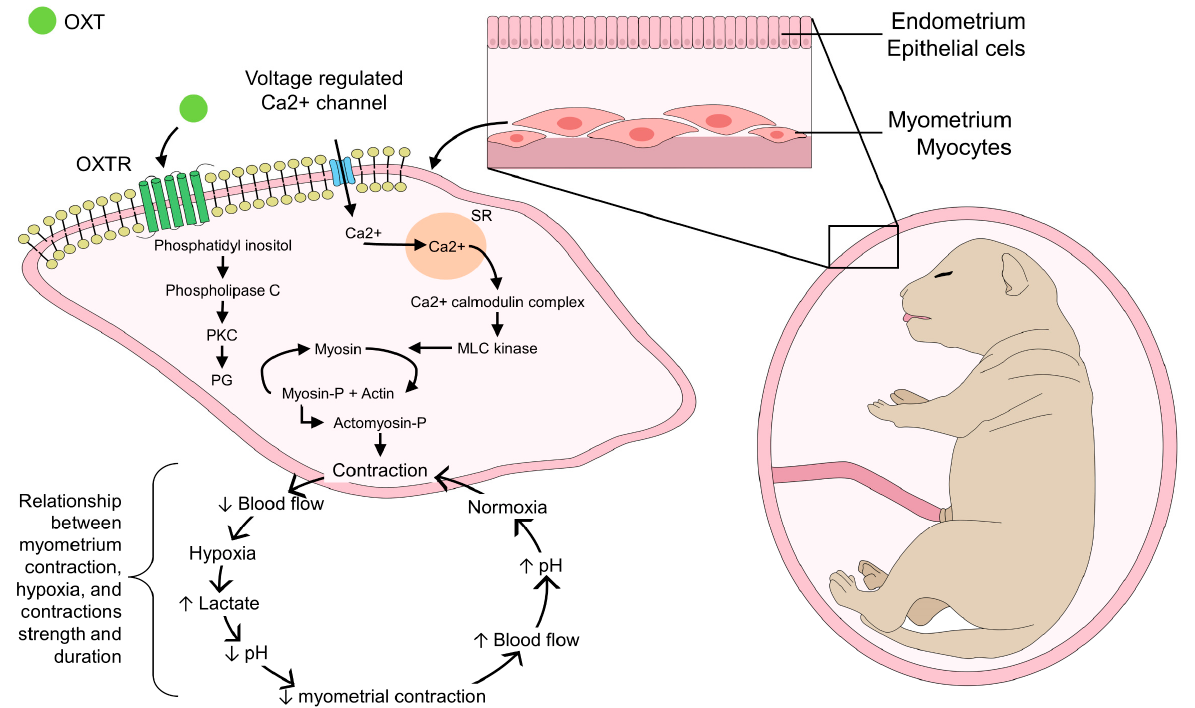
Figure 1. Mechanism of action of oxytocin during myometrial contractions. During parturition, the activation of OXTR at the uterus by OXT starts myometrial contractions. The interaction between OXTR and voltage-regulated Ca 2 + channels enables the formation of the actomyosin-P complex to produce myocytes’ contraction. After contraction starts, a relation between contraction maintenance and uterine blood flow is responsible for maintaining effective contraction movements and, therefore, a normal course during parturition. In the first instance, myometrial contractions cause compression of uterine blood vessels, reducing blood flow. Hypoxia induces an acidemia state, by lactate increase, which decreases Ca 2 + influx and, consequently, myometrial contractions stop, restoring blood flow and normoxia, in order to start another effective contraction. The ongoing maternal and fetal stimulation that promotes OXT release maintains rhythmic contractions due to initial hypoxia and acidemia of the myocytes, an effect that decreases contractions, and the cycle begins again when reaching normoxia and a regular uterine blood flow. MLC: myosin-light chain kinase; OXTR: oxytocin receptor; PG: prostaglandins; PKC: protein kinase C; SR: sarcoplasmic